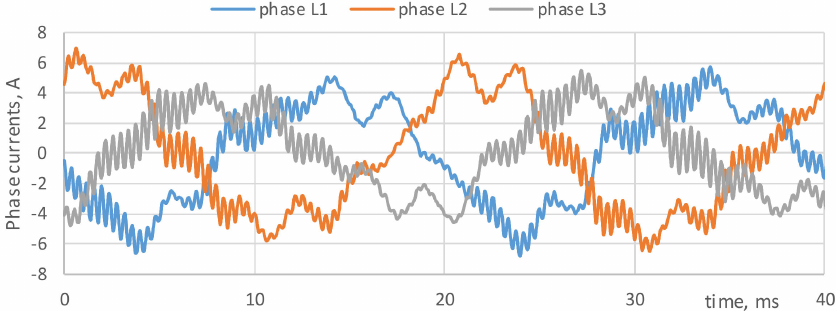
Figure 23. Exemplary MV phase current waveforms for the wind farm for generated active power equal to 95